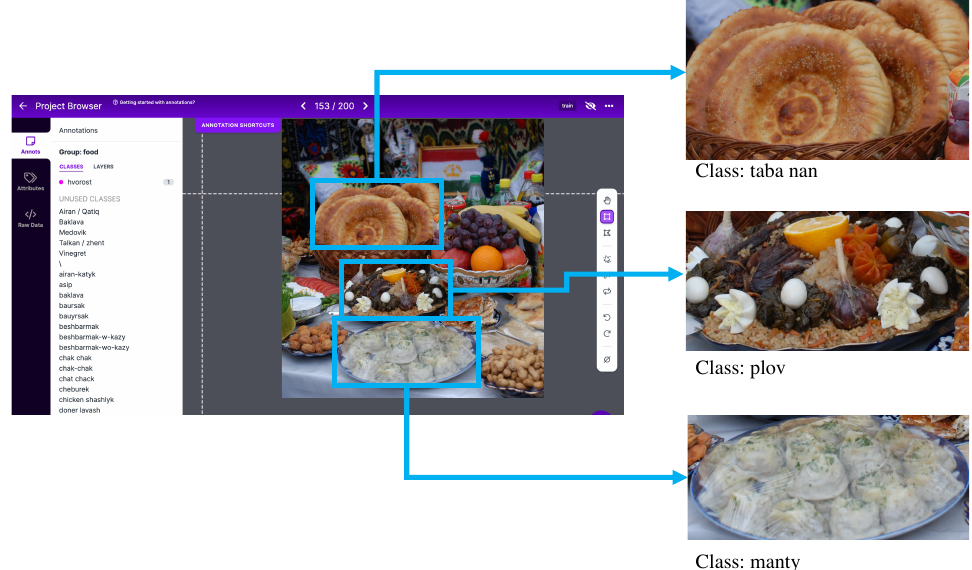
Figure 2. Data pre-processing: Food labeling and cropping on Roboflow. Original image and final cropped images with the respective